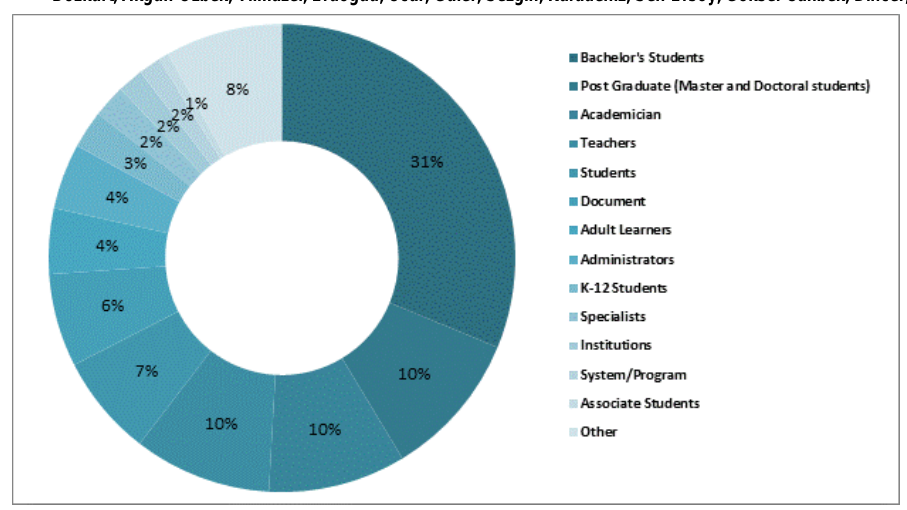
Figure 6 . Target groups and